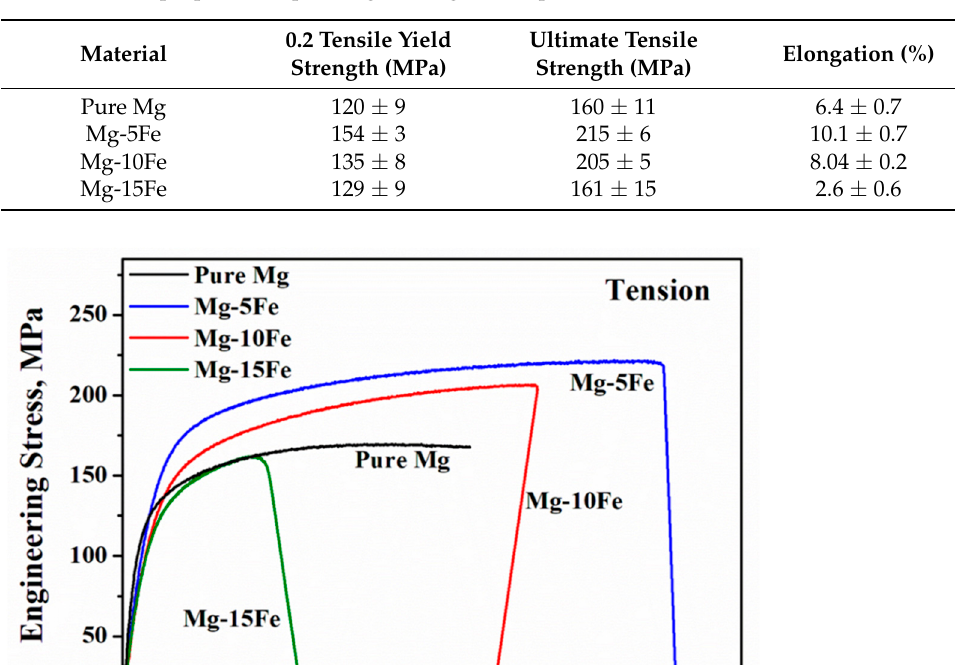
Table 3. Tensile properties of pure Mg and Mg-Fe composites.